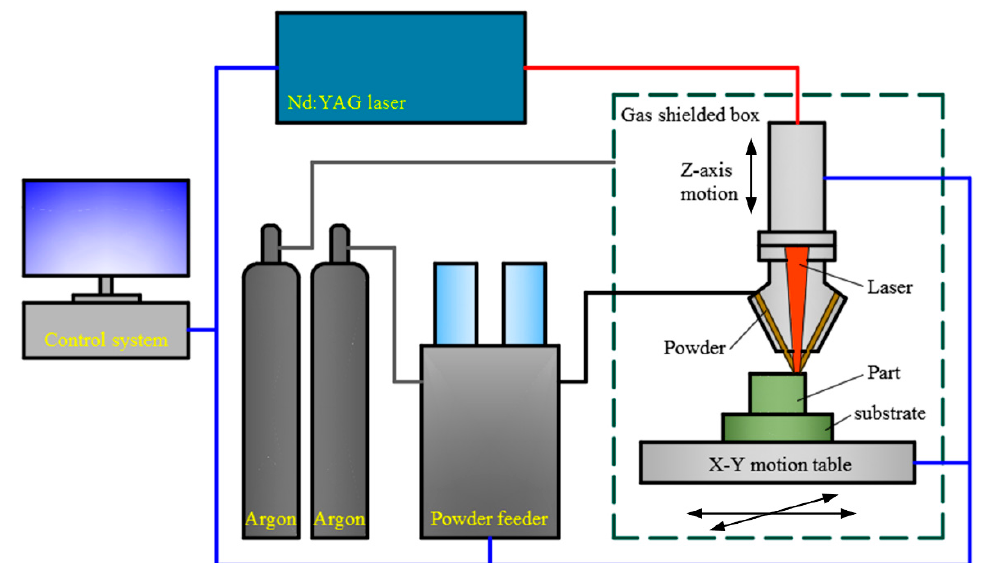
Figure 2. Schematic diagram of the laser cladding deposition (LCD) system. Table 2. Process parameters of laser cladding deposition.